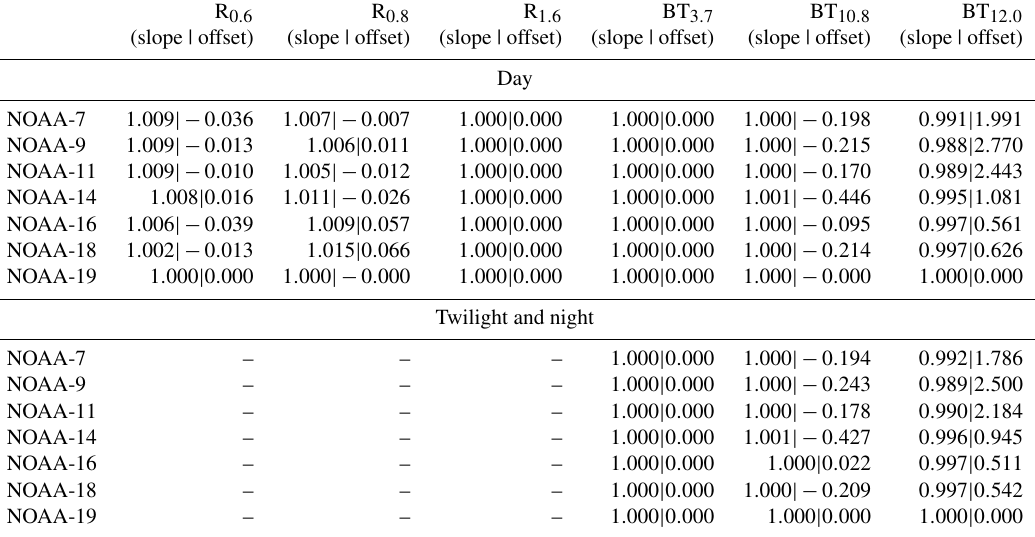
Table C1. Linear regression coefficients (slope and offset) applied as spectral-band adjustment to either measured reflectances (Rs) or brightness temperature (BTs) of all used AVHRR channels and all used sensors to mimic NOAA-19 AVHRR. The subscript in the table’s headline corresponds to the approximate central wavelengths of the channels: 0.6, 0.8, 1.6, 3.7, 10.8 and 12.0µm. Reflectances in channels 0.6, 0.8 and 1.6µm are generally not used in twilight and night conditions. R 0 .